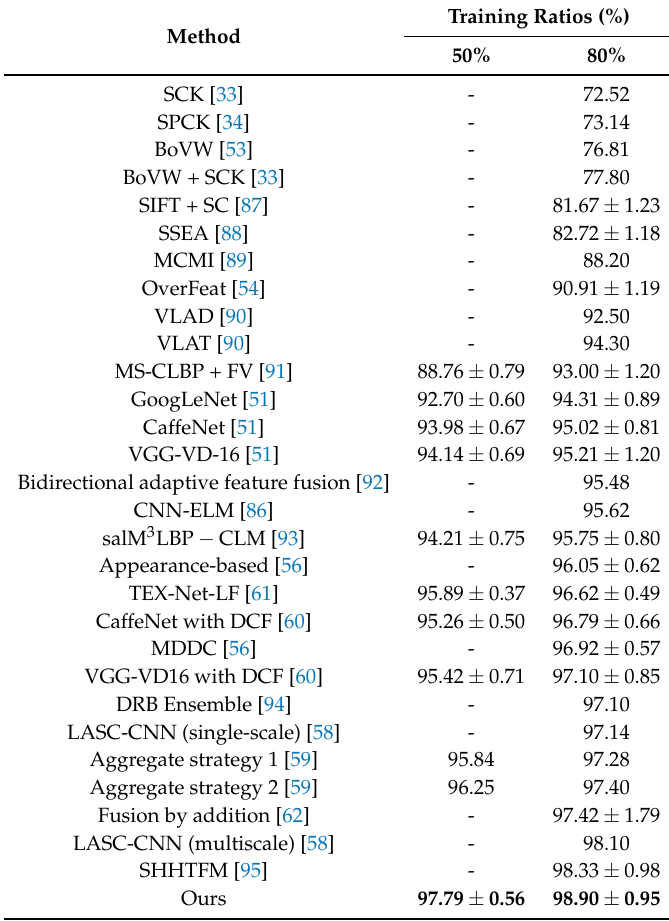
Table 5. Comparison of classification accuracy with the state-of-the-art methods on the UC-Merced dataset.